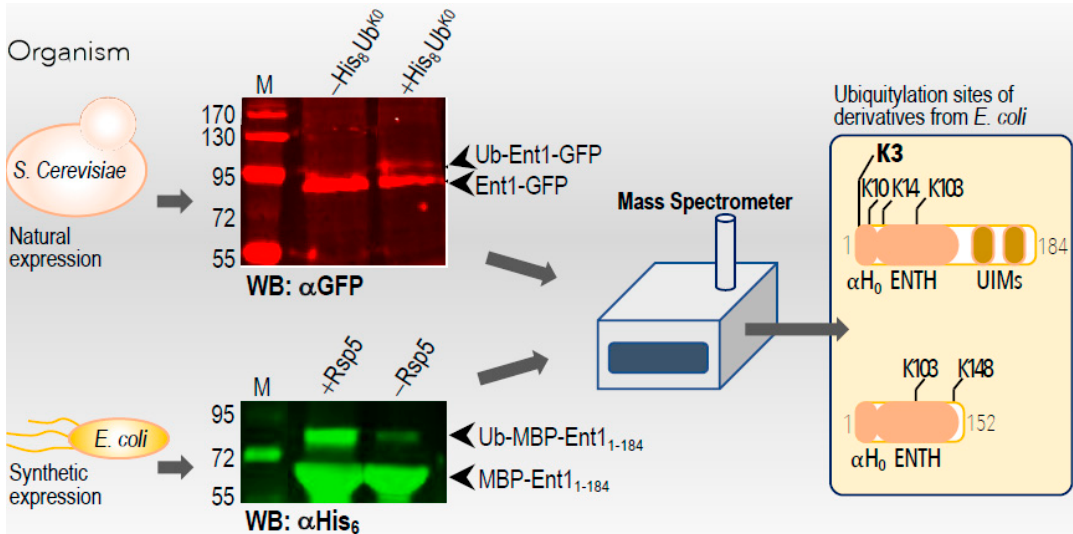
Figure 2. Mapping the ubiquitylation sites of Ent1. A scheme showing the approaches taken to identify the ubiquitylation sites of Ent1. S. cerevisiae and E. coli expression and purification systems described in the methods section. Purified proteins were subjected to western blot analysis with the indicated antibodies. The ubiquitylated lysine residues (Ks) identified by the mass spectrometry analysis are indicated.